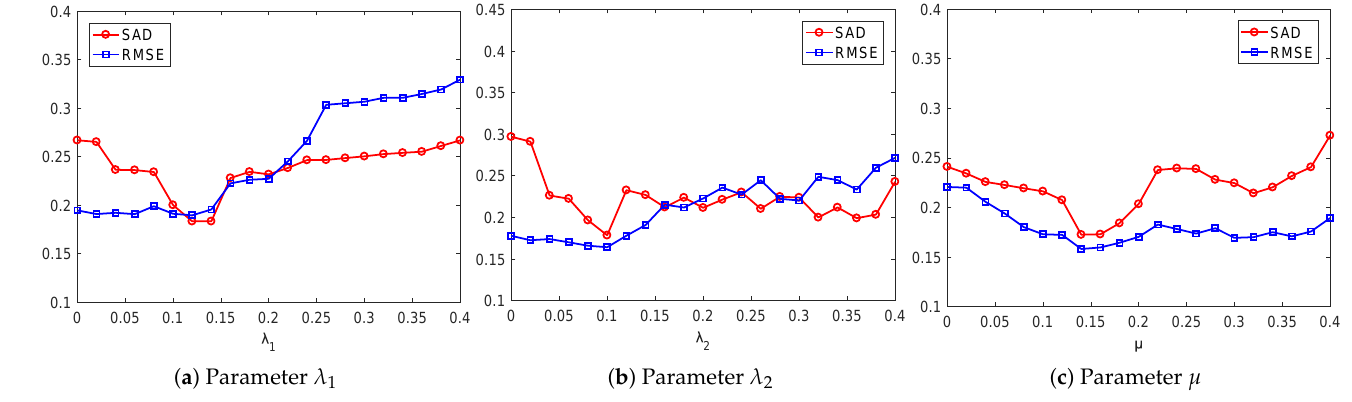
Figure 3. Algorithm parameter analysis about λ 1 , λ 2 , and µ